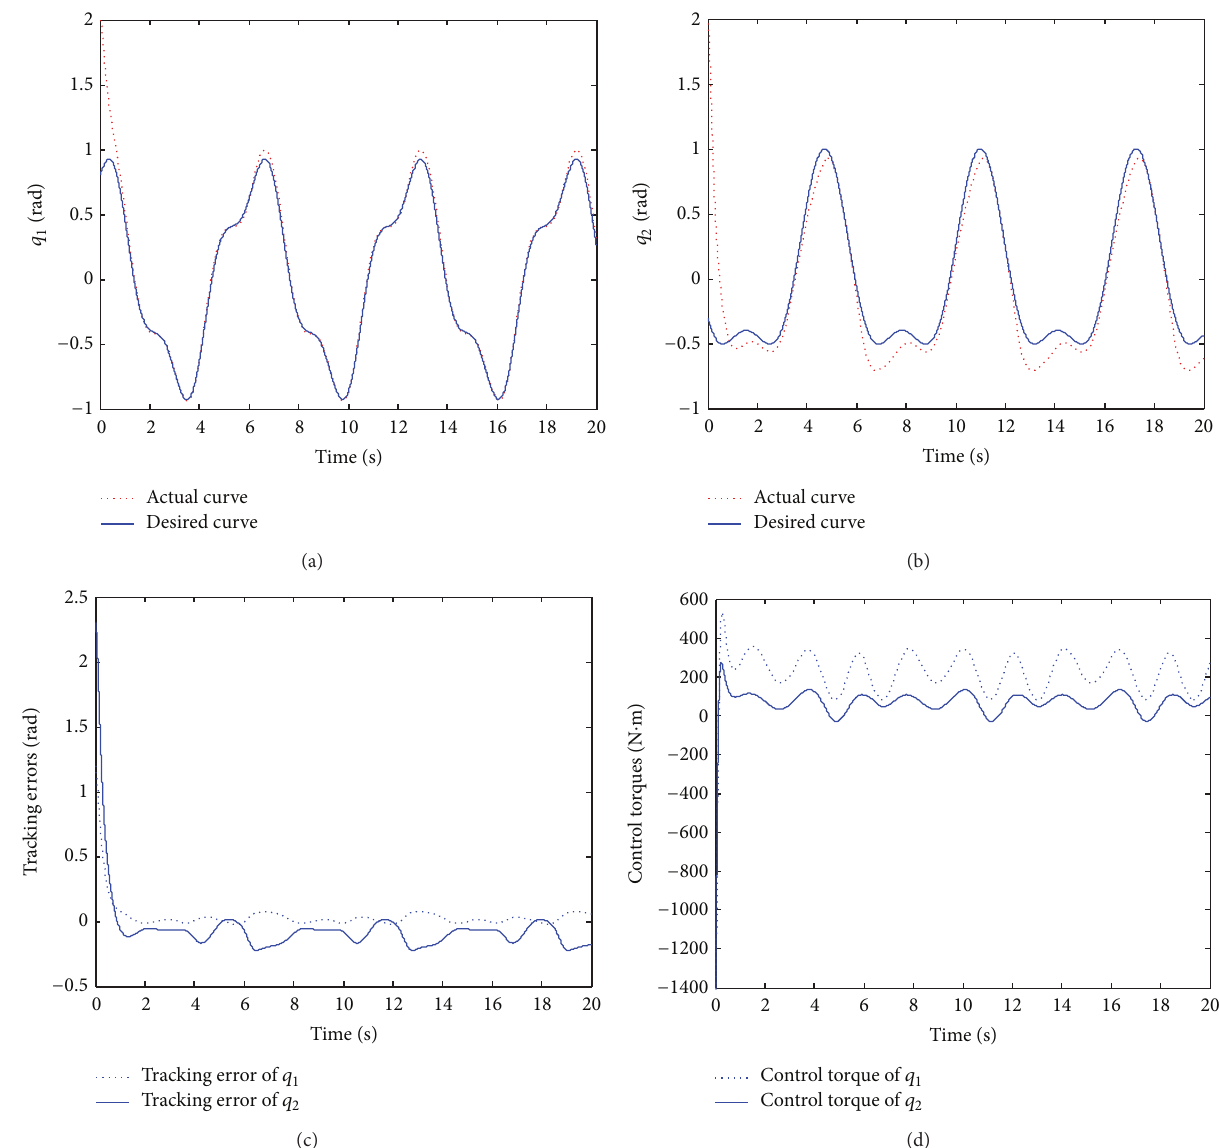
Figure 3: CTC for robotic manipulator with uncertainties and disturbances. (a) Tracking curve of 𝑞 1 , (b) tracking curve of 𝑞 2 , (c) tracking errors, and (d) control